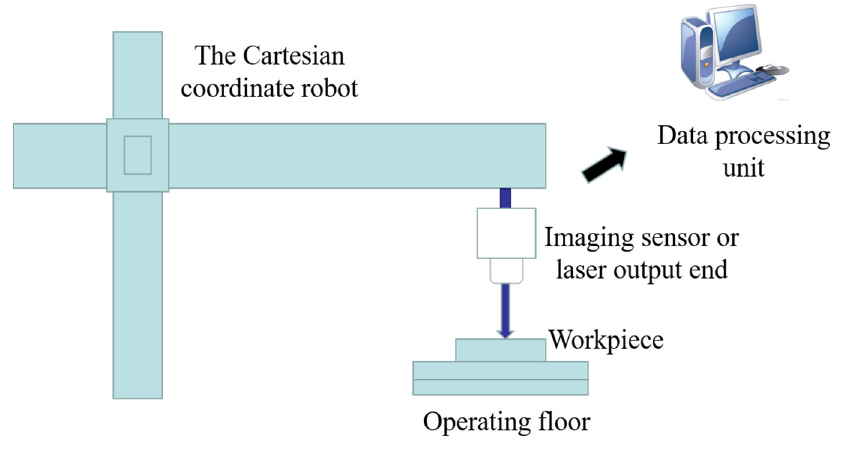
Figure 1. The sketch map of the lase cleaning implementation system.